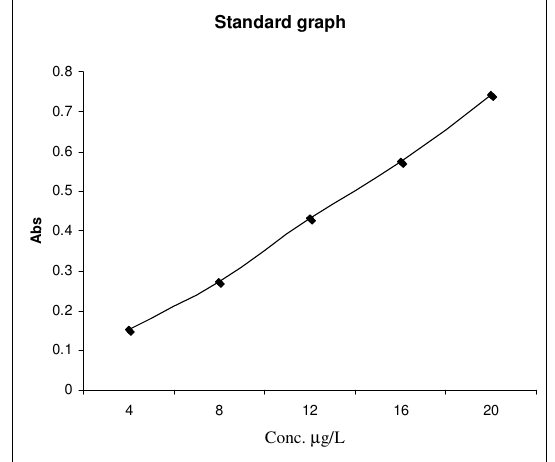
Conc. µ Figure 3. Calibration plot